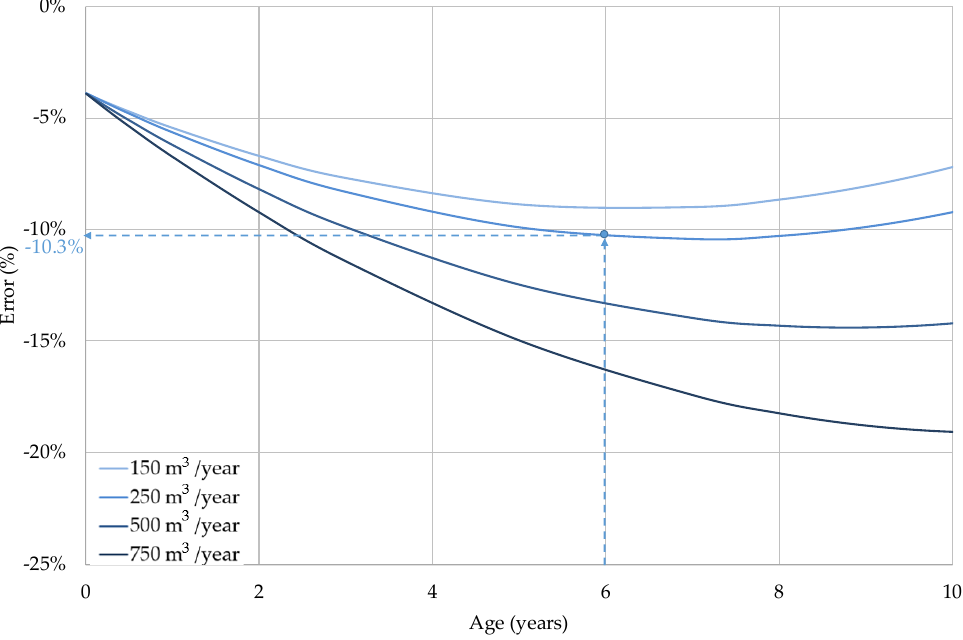
Figure 8. The degradation of the weighted error with age for different annual consumption rates (meter